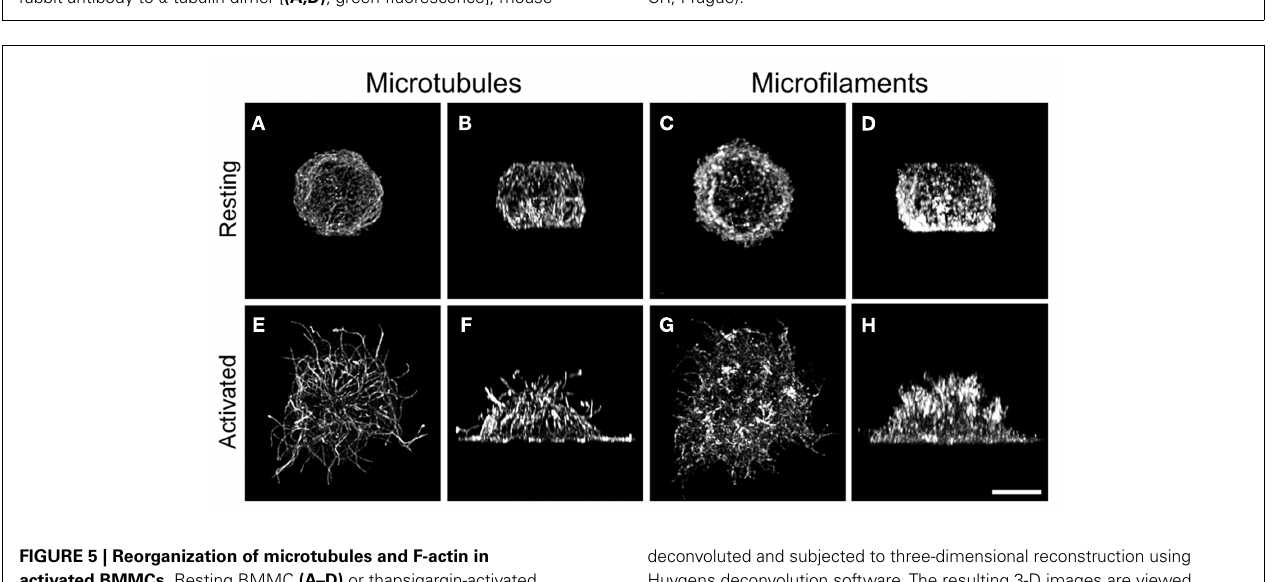
deconvoluted and subjected to three-dimensional reconstruction using Huygens deconvolution software.The resulting 3-D images are viewed from top of the cells (A,C,E,G) and from the plane perpendicular to the plane of cell adhesion (B,D,F,H) .The same cell is represented in (A–D) or (E–H) . Scale bar, 5 μ m. Photography Z. Hájková (Institute of Molecular Genetics AS CR,